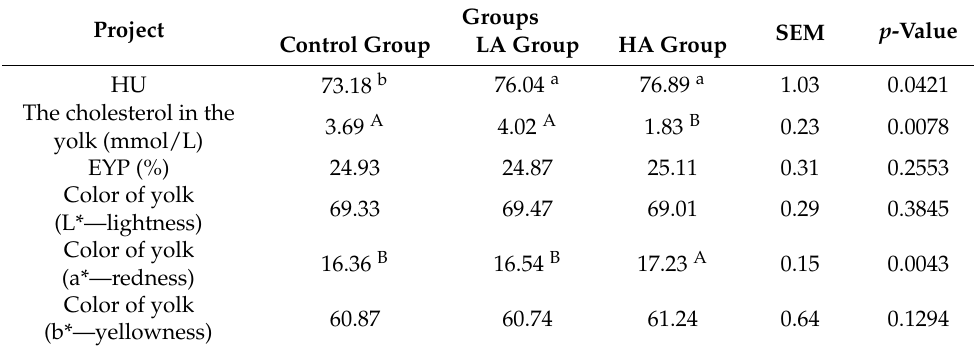
Table 5. Effects of dietary-supplemented Gynostemma pentaphyllum on the egg quality of laying hens.